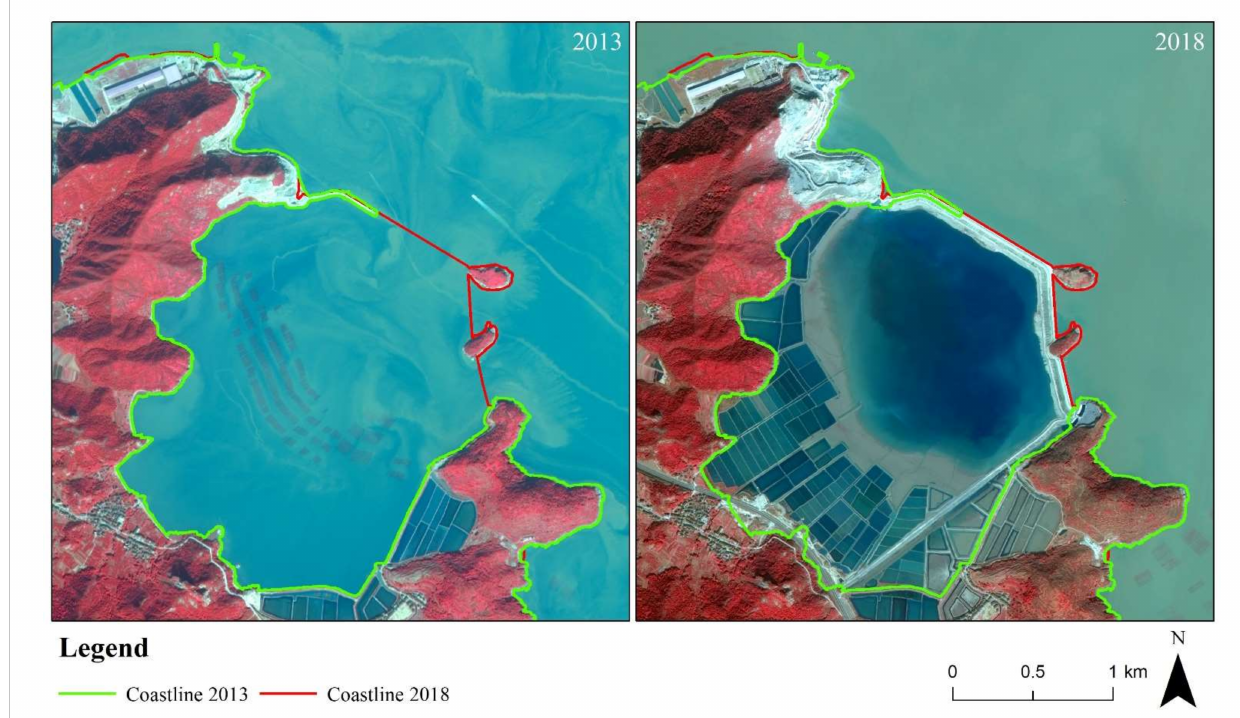
Figure 8. Coastline straightening in Zhejiang